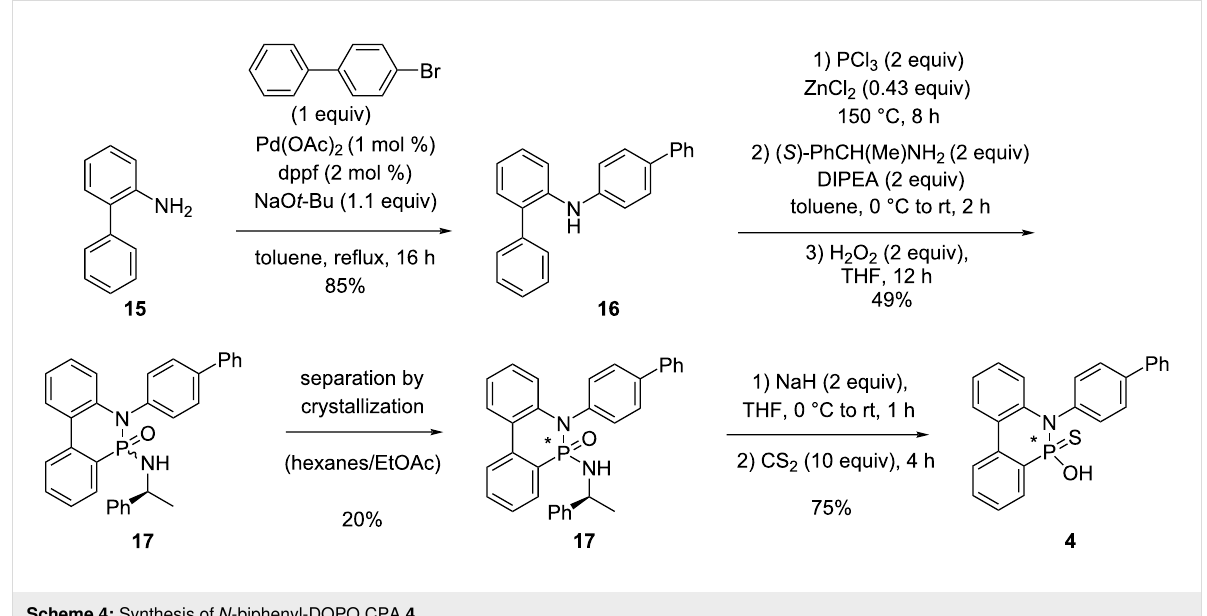
Scheme 4: Synthesis of N -biphenyl-DOPO CPA 4